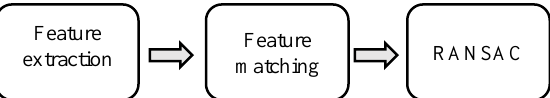
Figure 1. Traditional pipeline of removing the false positive